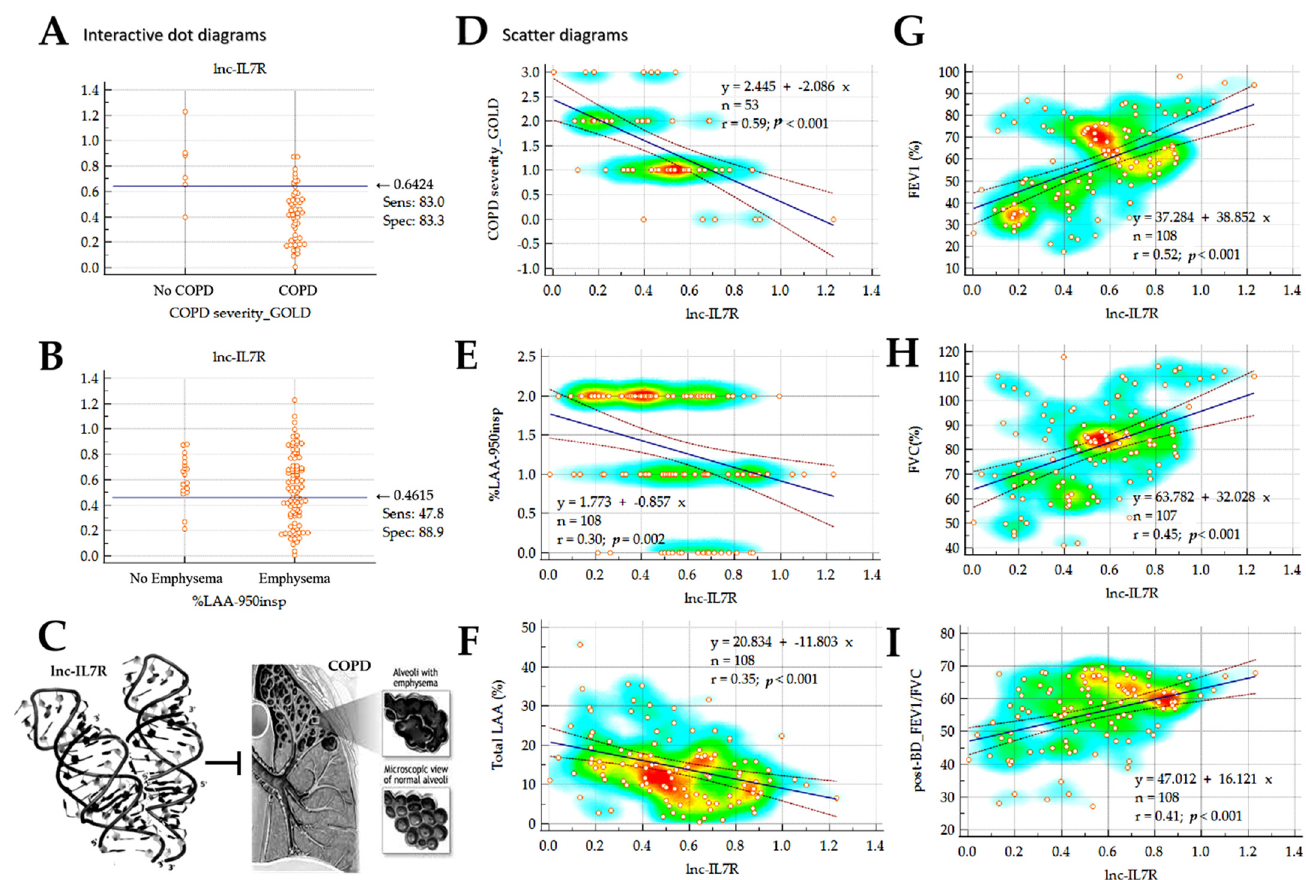
Figure 2. lnc-IL7R level correlates with COPD status and emphysematous phenotype, and its differen- tial expression reflects disease course. Dot plots showing stratification of patients into ( A ) No-COPD or COPD, and ( B ) No-Emphysema or Emphysema groups, based on the expression of lnc-IL7R . ( C ) Pictorial depiction of the inhibitory role of lnc-IL7R expression on COPD with/or emphy- sematous phenotype. Scatter heat map plots depicting the correlation between lnc-IL7R expression, and ( D ) GOLD-defined COPD severity, ( E ) %LAA -950insp -based Emphysema severity, ( F ) total LAA, ( G ) FEV 1 , ( H ) FVC, or ( I ) post-BD FEV 1 /FVC. LAA, lung attenuation area; %LAA -950insp , percentage of lung a tt enuation area with values less than − 950 Houns fi eld Units on inspiratory CT scan; BD, bronchodilator.